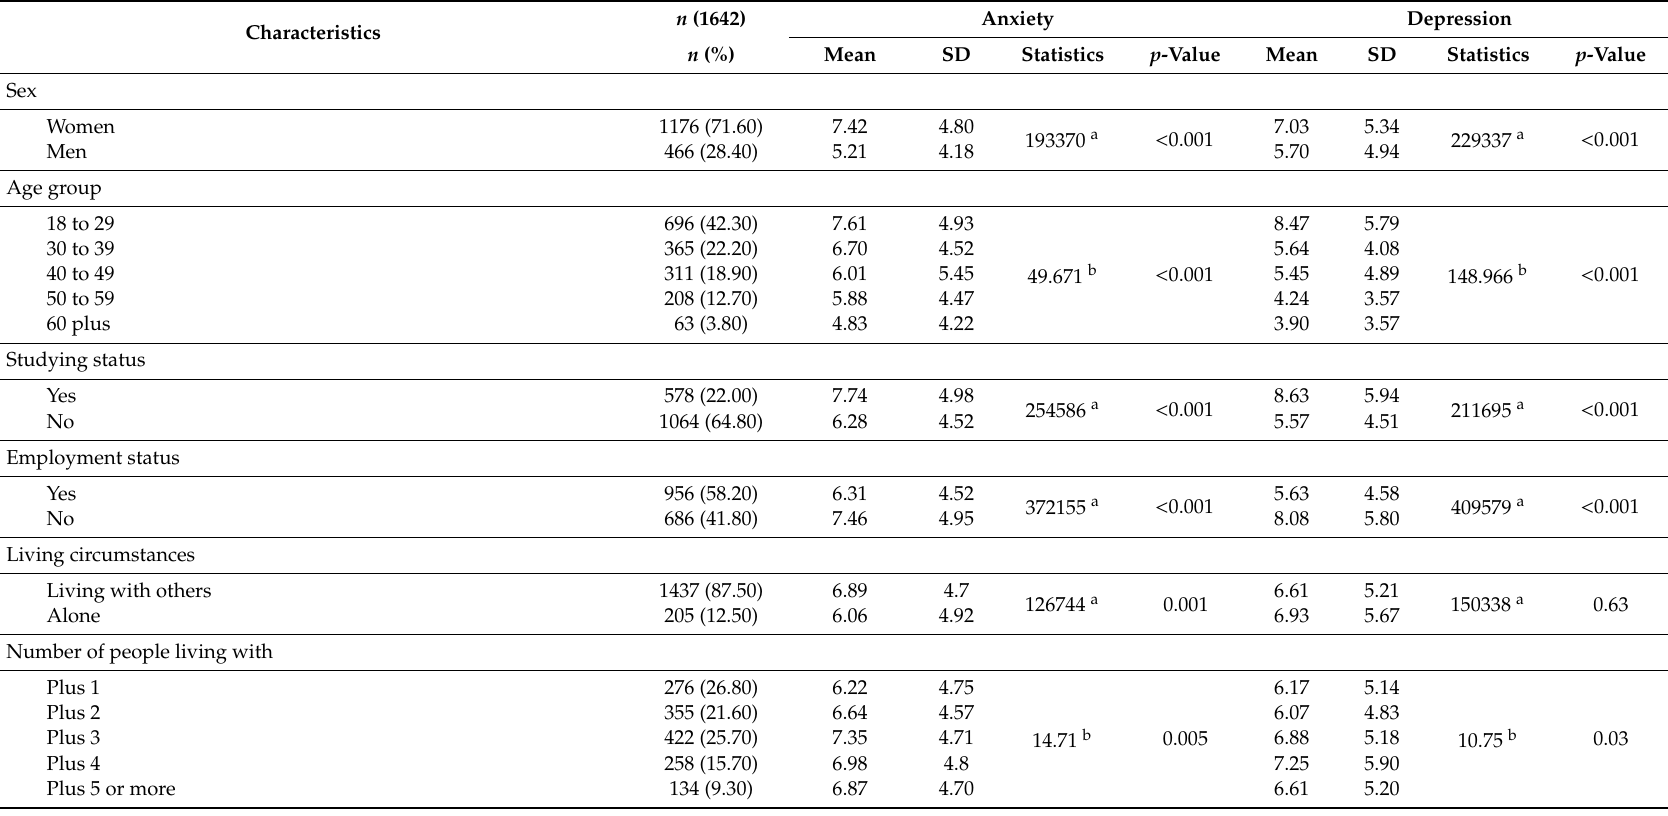
Table 1. Relationship between Sociodemographic Characteristic of the sample with anxiety and depression scores.